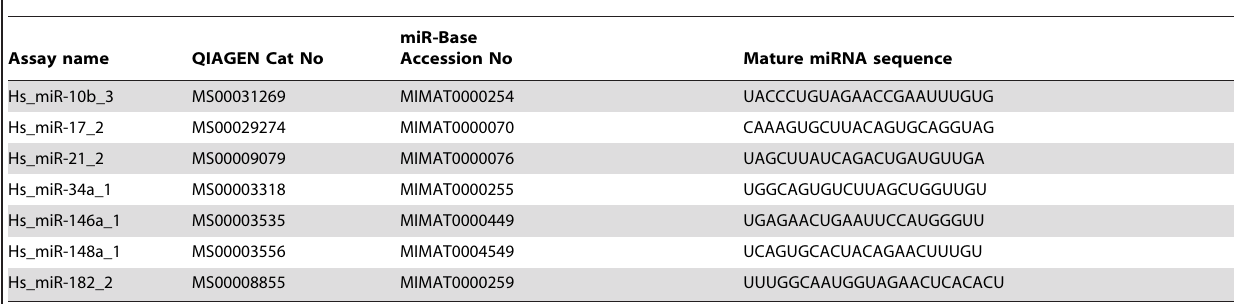
Table 2. List of the analyzed microRNAs.